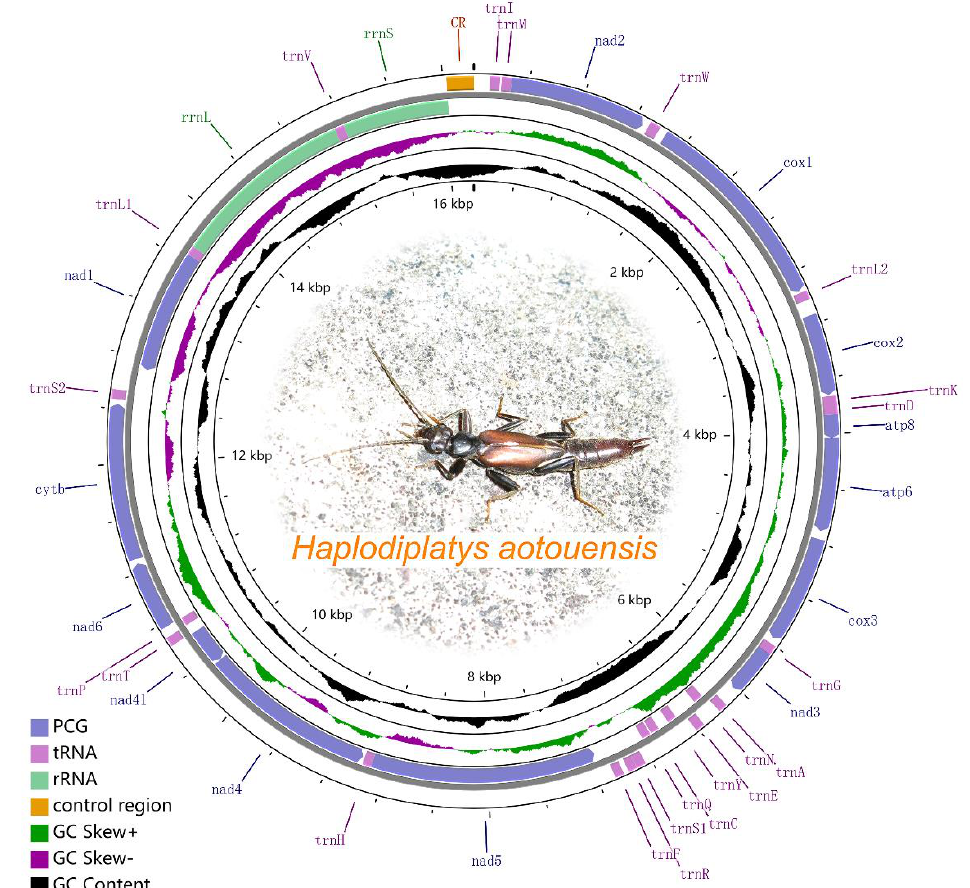
Figure 1. Consensus mitogenome structure of Haplodiplatys aotouensis . The map is generated based on Fujian’s sample. Genes outside the map are transcribed clockwise, while those inside the map are transcribed counterclockwise. Names and other details of the genes are listed in Table 2. The inside circles show the GC content and the GC skew. GC content and GC skew are plotted as the deviation from the average value of the entire